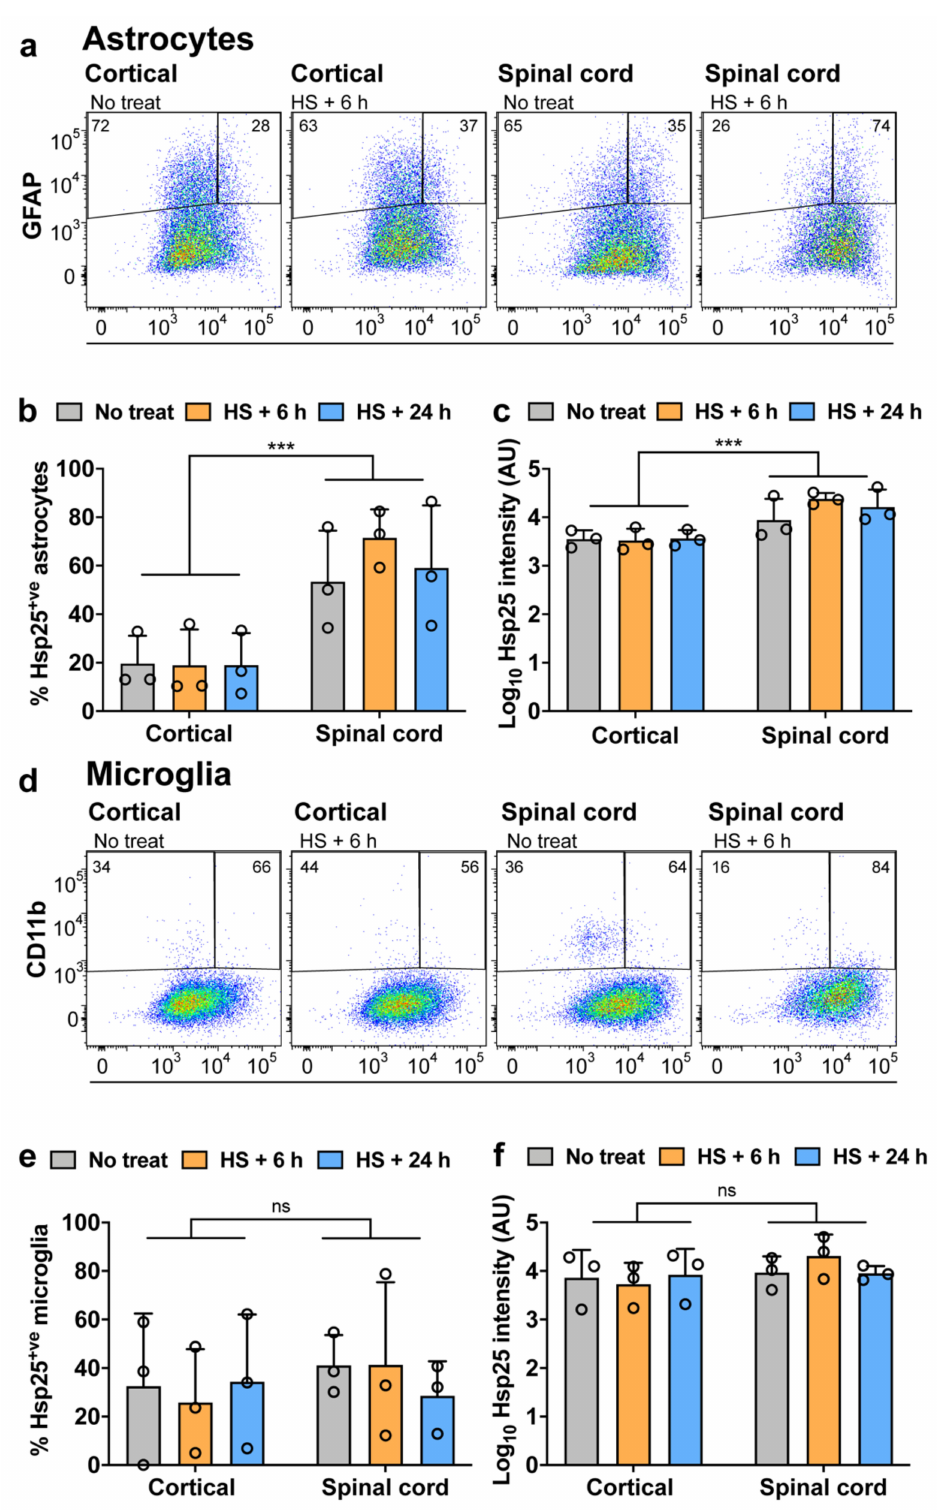
Figure 3. Flow cytometric analysis of Hsp25 expression in astrocytes and microglia after heat shock. Mixed primary cortical and spinal cord glia were heat shocked at 42 ◦ C for 30 min and allowed to recover at 37 ◦ C for 6 or 24 h. Cells were then fixed, permeabilised, immunolabelled for GFAP-Cy3, CD11b-APC/Cy7 and Hsp25-AF488 and analysed by flow